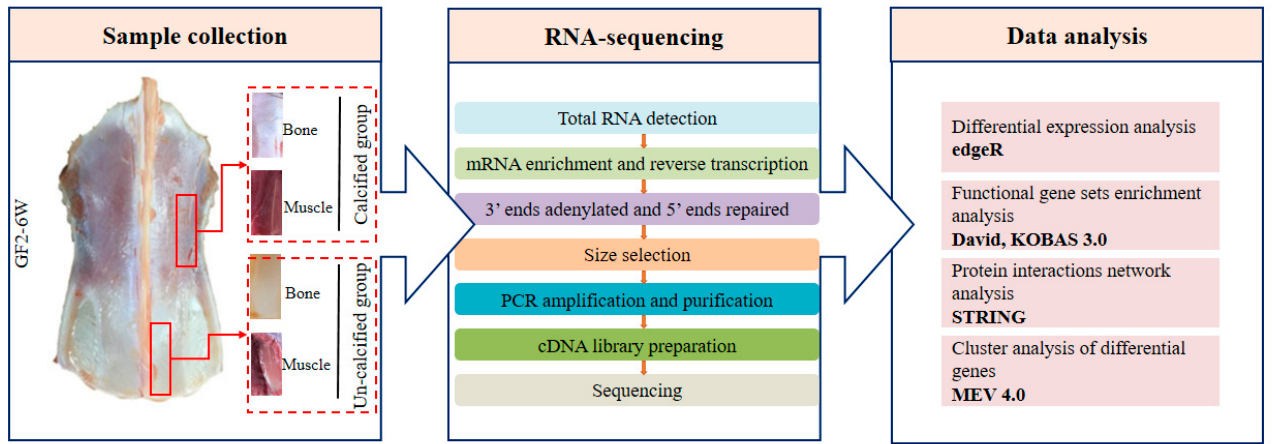
Figure 1. Sample collection and transcriptome data analysis